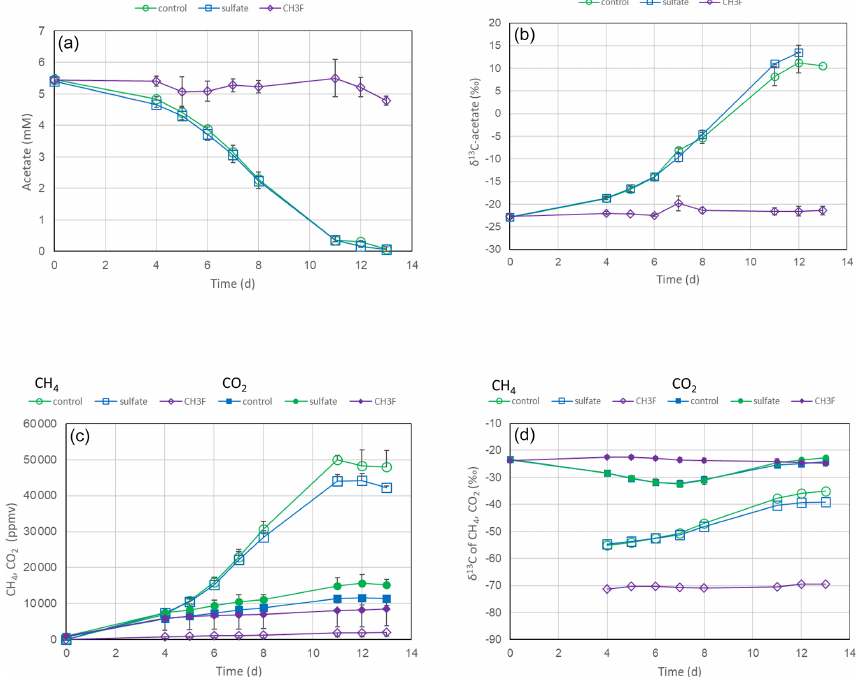
Figure 1. Acetate conversion to CH 4 and CO 2 in unbuffered suspensions of paddy soil from the IRRI (the Philippines) without additions (water control), with gypsum and with CH 3 F. The panels show the temporal change of (a) concentrations of acetate, (b) δ 13 C of acetate,